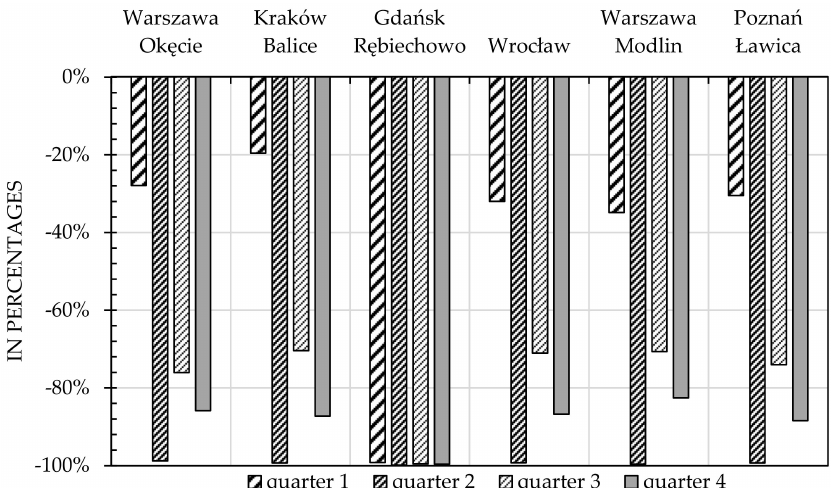
Figure 9. Average annual losses in millions of EUR.